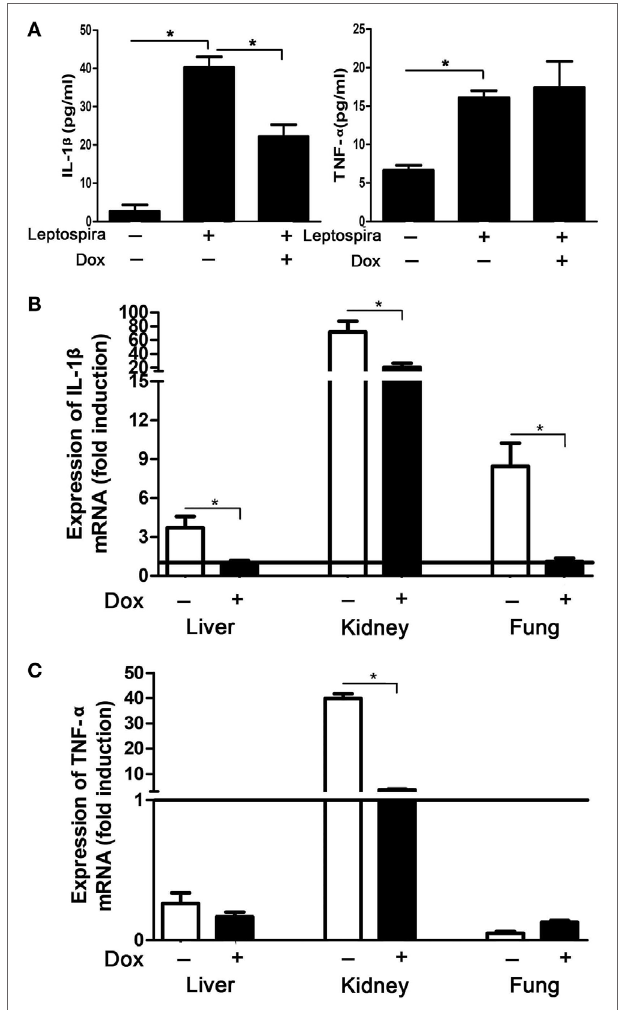
FigUre 6 | Doxycycline (Dox) downregulated leptospira-induced IL-1 β in mice and hamsters. (a) Mice were injected intraperitoneally with Dox before 24 h inoculated intraperitoneally with 2 × 10 8 sonicated leptospira. Another 24 h later, the peritoneal cavities were lavaged and the IL-1 β and TNF- α were analyzed by enzyme-linked immunosorbent assay. Bars show the mean ± SD of three independent experiments and analyzed by the one-way ANOVA. * p < 0.05. (B,c) Hamsters were infected 10 7 live leptospira and treated with Dox. At the 96 h after infection, the mRNA expression of IL-1 β (B) and TNF- α (c) were analyzed by quantitative real-time polymerase chain reaction. Results were normalized to the expression of the housekeeping gene GAPDH. The mRNA levels of cytokines in untreated controls were set as 1.0 (solid line). Bars show the mean ± SD of three independent experiments and analyzed by the one-way ANOVA. * p <